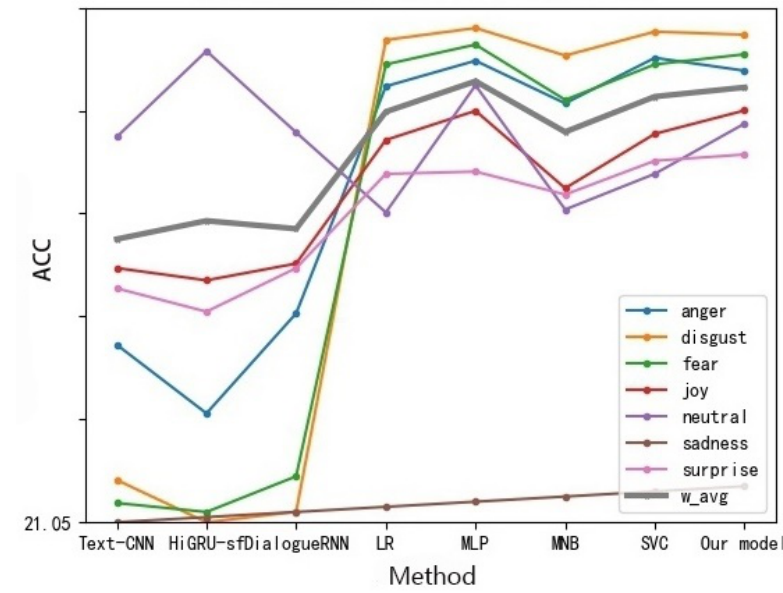
Figure 6. Fine-grained Emotion Accuracy Rate of Different Methods of MELD Data Set